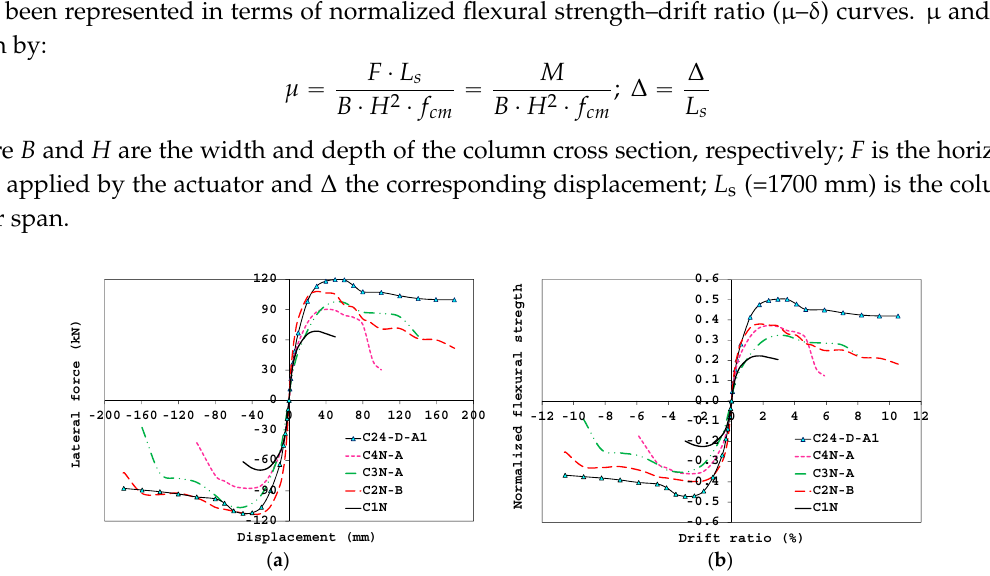
Figure 9. F ‒Δ envelopes ( a ) and μ‒δ envelopes ( b ) under ν = 0.40.